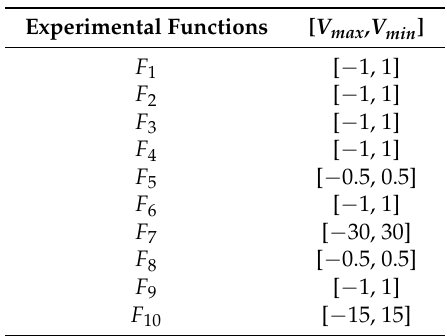
Table 5. Parameter settings of PSO.